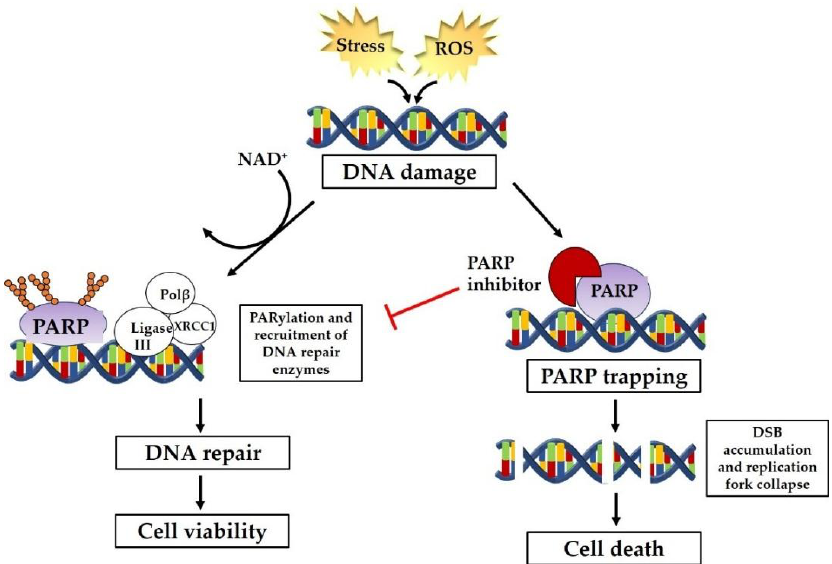
Figure 1. PARP pathway overview. Cellular stress such as oxidative stress from reactive oxygen species causes DNA damage in the form of single- and double-strand breaks. Under normal